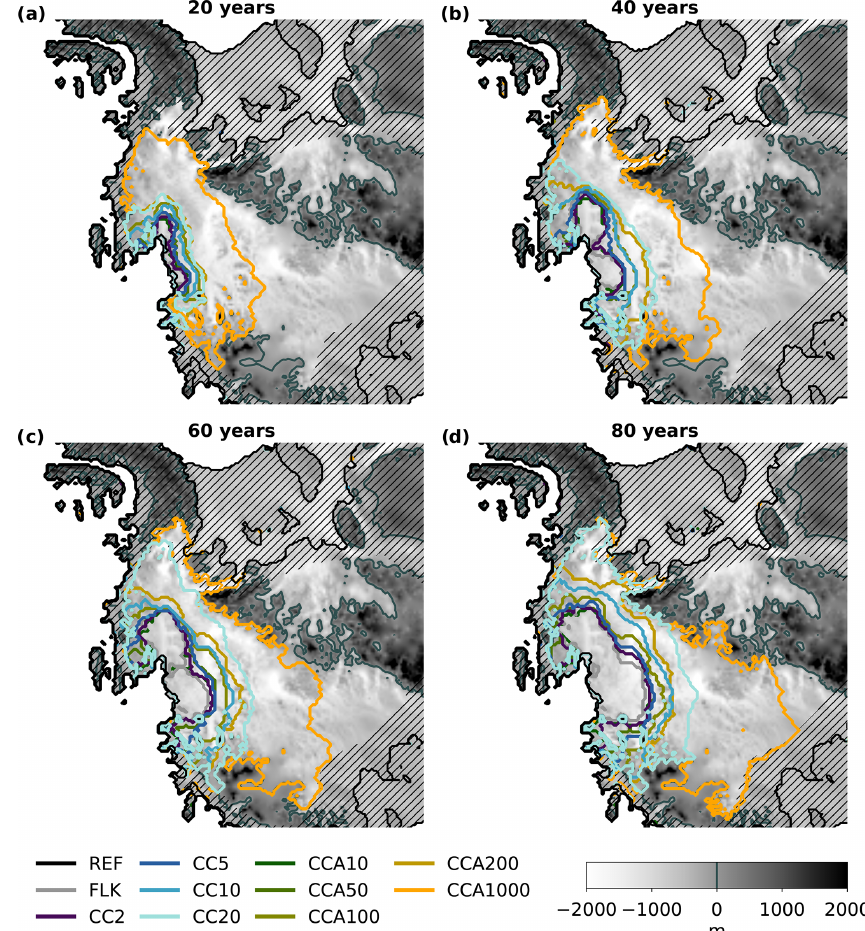
Figure 5. Maps of grounding-line retreat in the WAIS, underlaid with the bed topography. In the shaded region, neither the floatkill parame- terization nor cliff calving is applied (see Sect. 2.2.3). Grounding-line retreat of CCA1000, the fastest experiment, halts when it reaches bed topography above sea level (in which case cliff calving is no longer applied) or the margin of the interior Amundsen region domain (beyond which neither floatkill nor cliff calving is applied). Table 3. Upper bound on calving rates for the adaptive cliff-calving experiments (CCA#) in kma − 1 . Where two values are given, the first is for Thwaites Glacier and the second for Pine Island Glacier. Where only one value is given, both glaciers share one embayment. 0a 20a